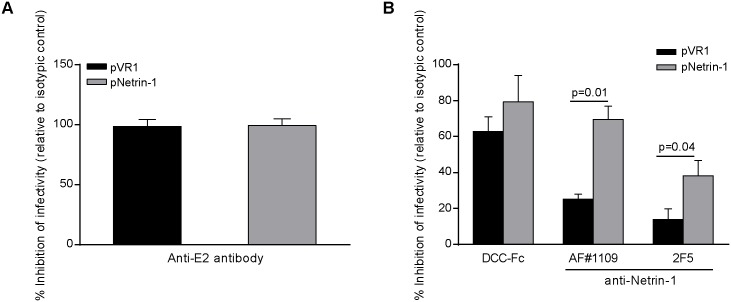
Netrin-1 is virion-bound and participates in the infectivity of viral particles.HCV particles produced in cells overexpressing Netrin-1 have been preincubated with Netrin-1 antagonists and TCID50 has been performed. A. Method validation: inhibition of HCV infectivity after incubation with anti-E2 antibody. The anti-E2 antibody was used as a control of neutralization of infectivity. B. Inhibition of HCV infectivity after incubation with three distinct Netrin-1 antagonists (data are represented as mean ± standard deviation, n = 3, Mann-Whitney test, p < 0.05). The underlying data for panels in this figure can be found in S1 Data.